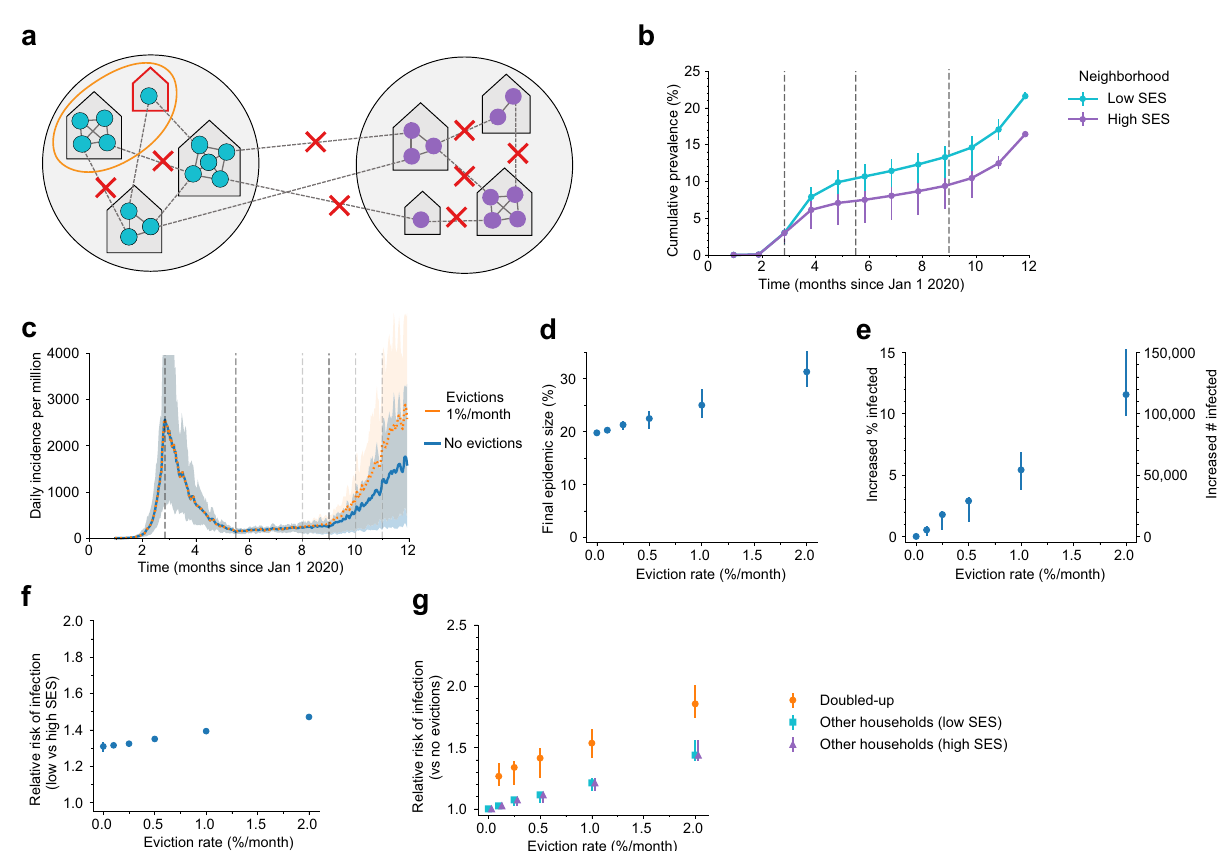
Fig. 4 Impact of evictions on COVID-19 epidemics in heterogeneous cities. a Schematic of our model for inequalities within a city. The city is divided into a “ high socioeconomic status (SES) ” (purple) and a “ low SES ” (teal) neighborhood. Evictions only occur in the low SES area, and individuals living in this area are assumed to be less able to adopt social distancing measures, and hence have higher contact rates under interventions (90% vs. 80% reduction in external contacts during lockdown for 85% overall, 75% vs. 65% during a relaxation for 70% overall, and 65% vs. 55% during fall comeback for 60% overall). Before interventions, residents are equally likely to contact someone outside the household who lives within vs. outside their neighborhood. b Cumulative percent of the population infected over time, by neighborhood, in the absence of evictions. Error bars show interquartile ranges across simulations. c The projected daily incidence of new infections (7-day running average) with 1%/month evictions vs. no evictions. Shaded regions represent central 90% of all simulations. d Final epidemic size by Dec 31, 2020, measured as percent individuals who had ever been in any stage of infection, for the heterogeneous city as compared to a homogenous city with the same effective eviction rate and intervention ef fi cacy. e The predicted increase in infections due to evictions through Dec 31, 2020, measured as the excess percent of the population infected (left Y -axis) or the number of excess infections (right Y - axis). f Relative risk of infection by Dec 31, 2020, for residents of the low SES vs. high SES neighborhood. g The relative risk of infection by Dec 31 2020 in the presence vs. absence of evictions, for individuals who merged households due to evictions ( “ Doubled-up ” ) and for individuals who kept their pre- epidemic household ( “ Other households ” ). Data in b , ( d – g ) shown as median values with interquartile ranges across simulations.